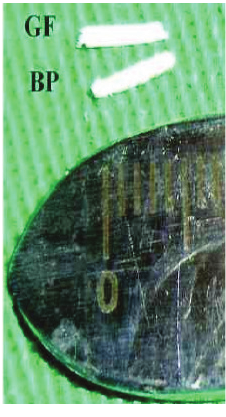
Figure 3 Materials studied. GF, Gelfoam (absorbable gelatine sponge); BP, sponge of sugarcane